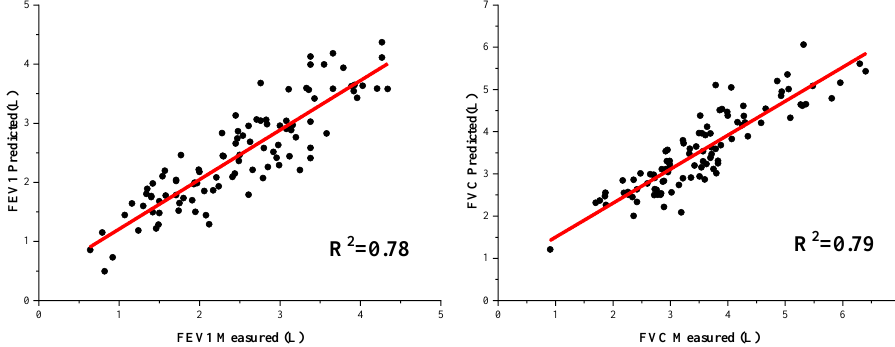
Figure 7. The fitting curves of the conventional machine learning results.